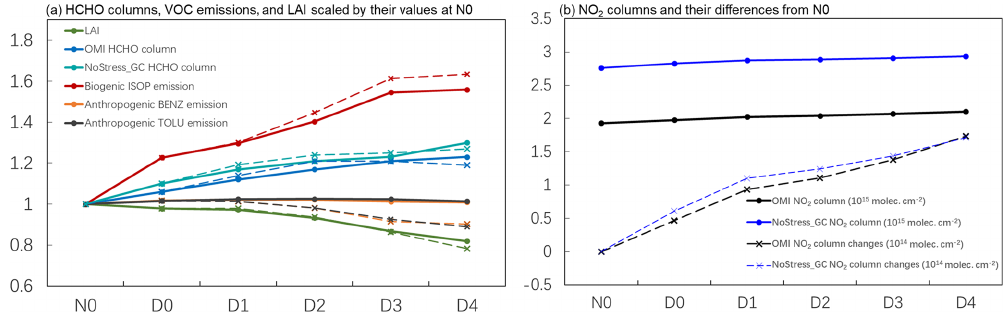
Figure 4. (a) Relative changes in the regional-mean OMI HCHO column and NoStress_GC simulated HCHO column; isoprene, anthro- pogenic benzene, and anthropogenic toluene emissions; and MODIS leaf area index (LAI) under different drought levels in the SE US. All data are scaled to their respective values at N0. The dotted lines are the arithmetic mean of all grids, and the solid lines are the corrected mean excluding the missing area. (b) Regional-mean tropospheric NO 2 columns from OMI and NoStress_GC (solid lines) as well as their respec- tive changes from non-drought (N0) conditions (dashed lines). Note the different scales between the solid and dashed lines. The calculation is based on the grids with the presence of all USDM